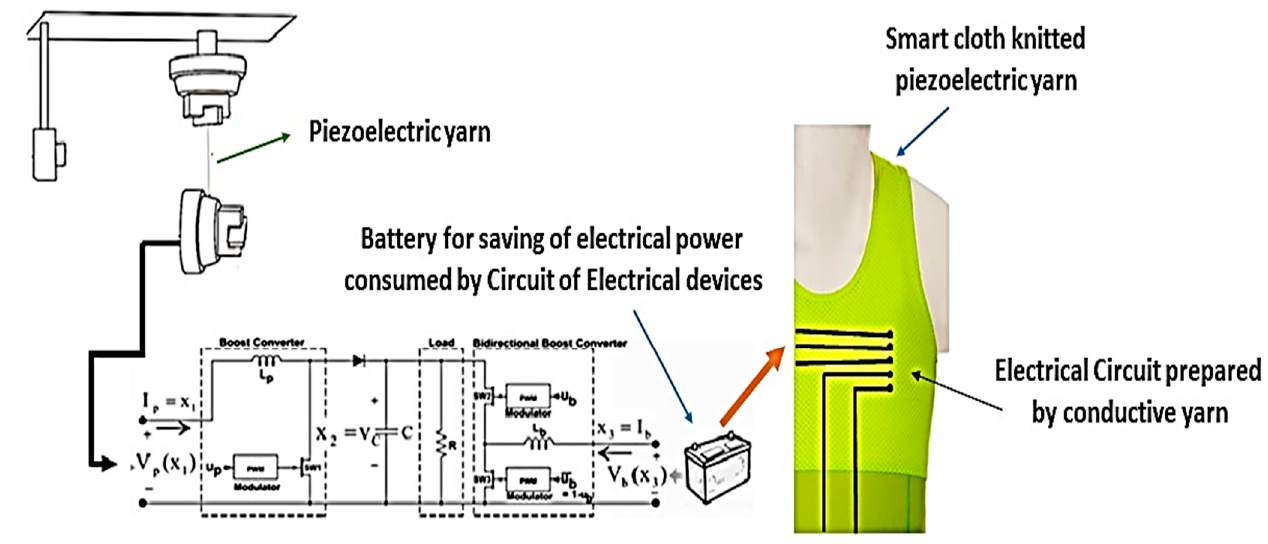
Figure 1. A view of the process under study.